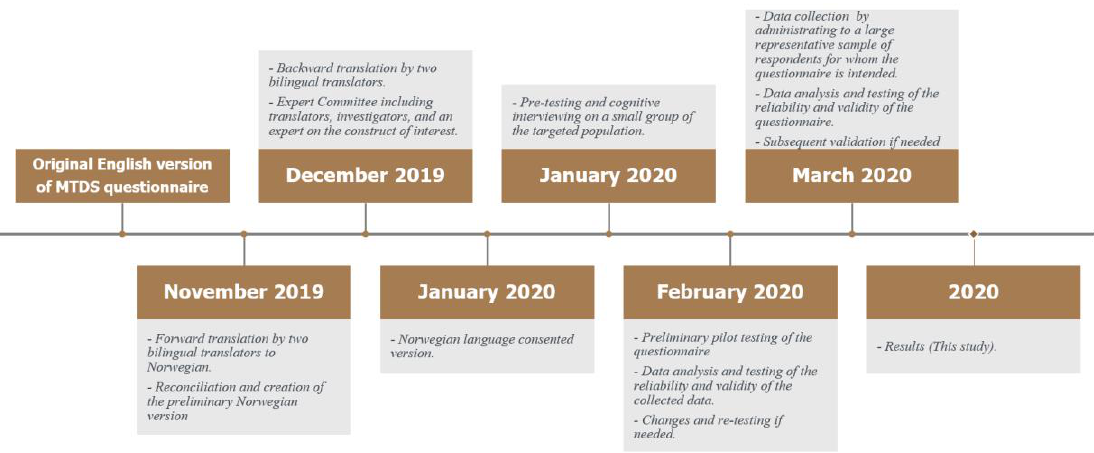
Figure 1. Figure 1. The process of translating Multicomponent Training Distress Scale (MTDS) to the Norwegian Norwegian context.